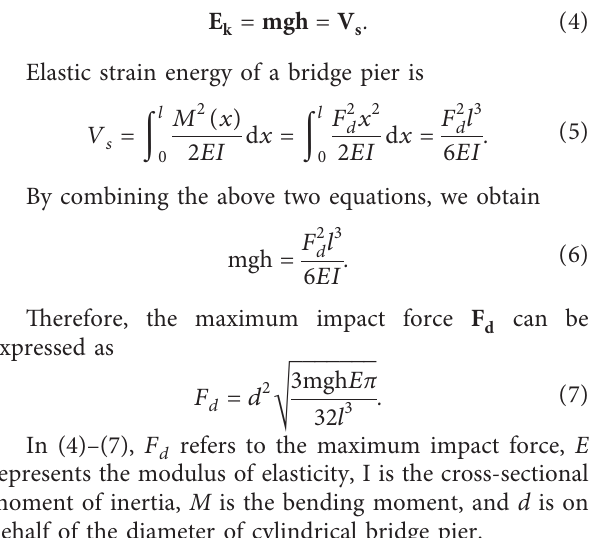
Table 6: The number of grids of spalled concrete at the impact position.